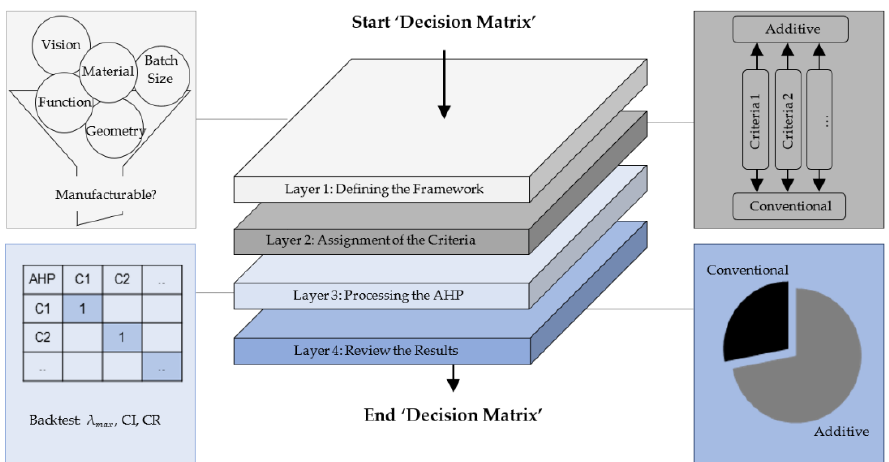
Figure 2. Multi-criteria decision-making process between AM and conventional manufacturing.